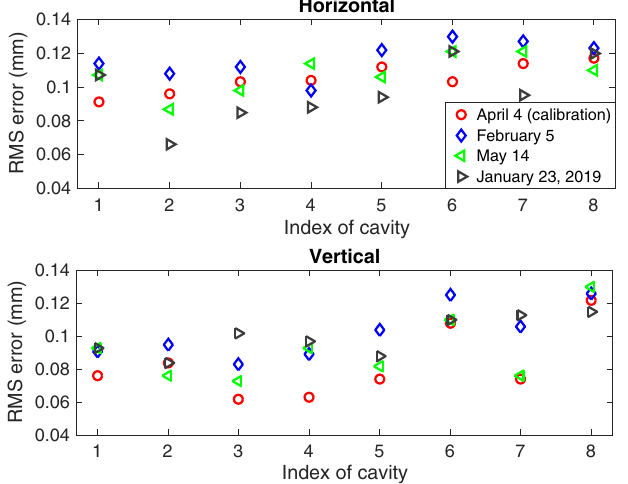
FIG. 16. Correlation between beam position reading of the HOMBPM in cavity four and the prediction from the others in the horizontal plane. Fig. 17. For each cavity, a resolution better than 10 μ m